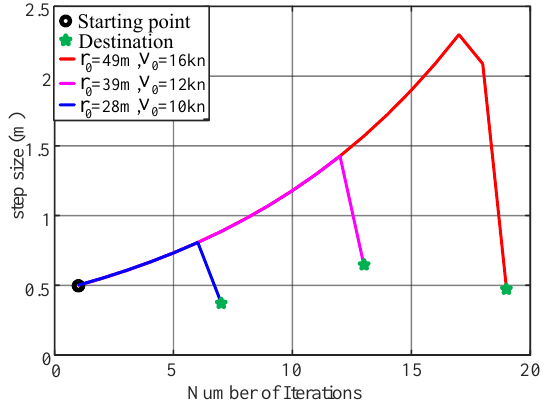
Figure 11. Step-size variations of the optimization process.